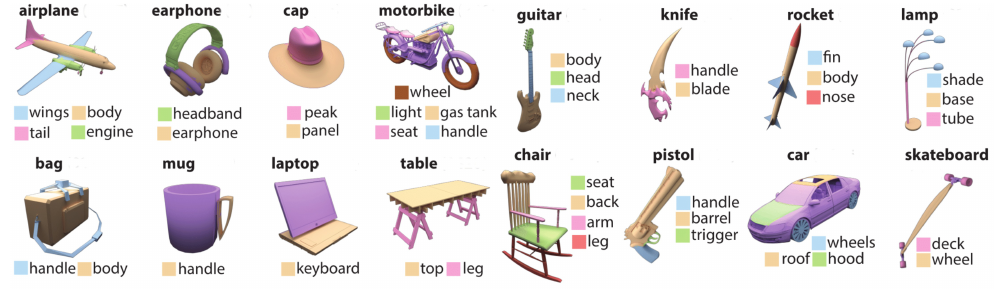
Figure 2. ShapeNet-part 3D point cloud objects [16]. Table 3. Description of ShapeNet-part segmentation data. We denote with n the number of annotated parts. We further show the training, validation, and test splits with the total number of samples per